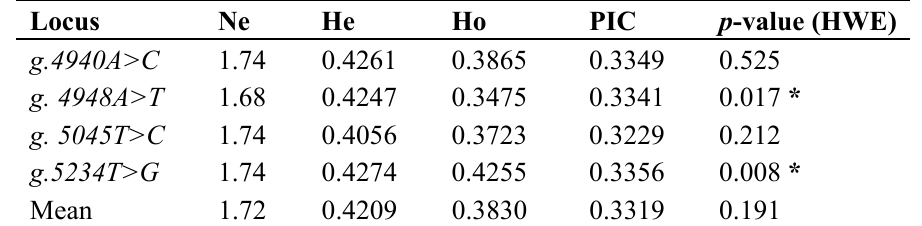
Table 1. Diversity parameters of four single nucleotide polymorphisms (SNPs) within the S. chuatsi Growth hormone ( GH ) gene. Locus Ne He Ho PIC p -value (HWE)